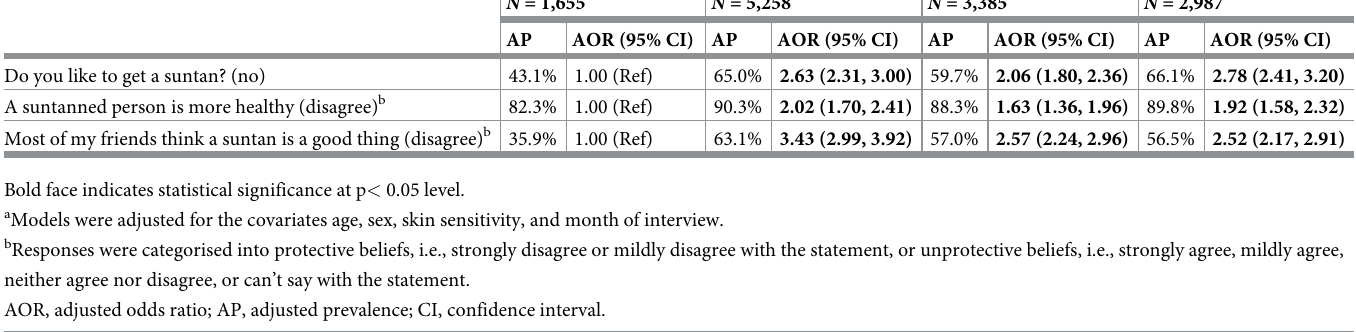
Tanning attitudes b